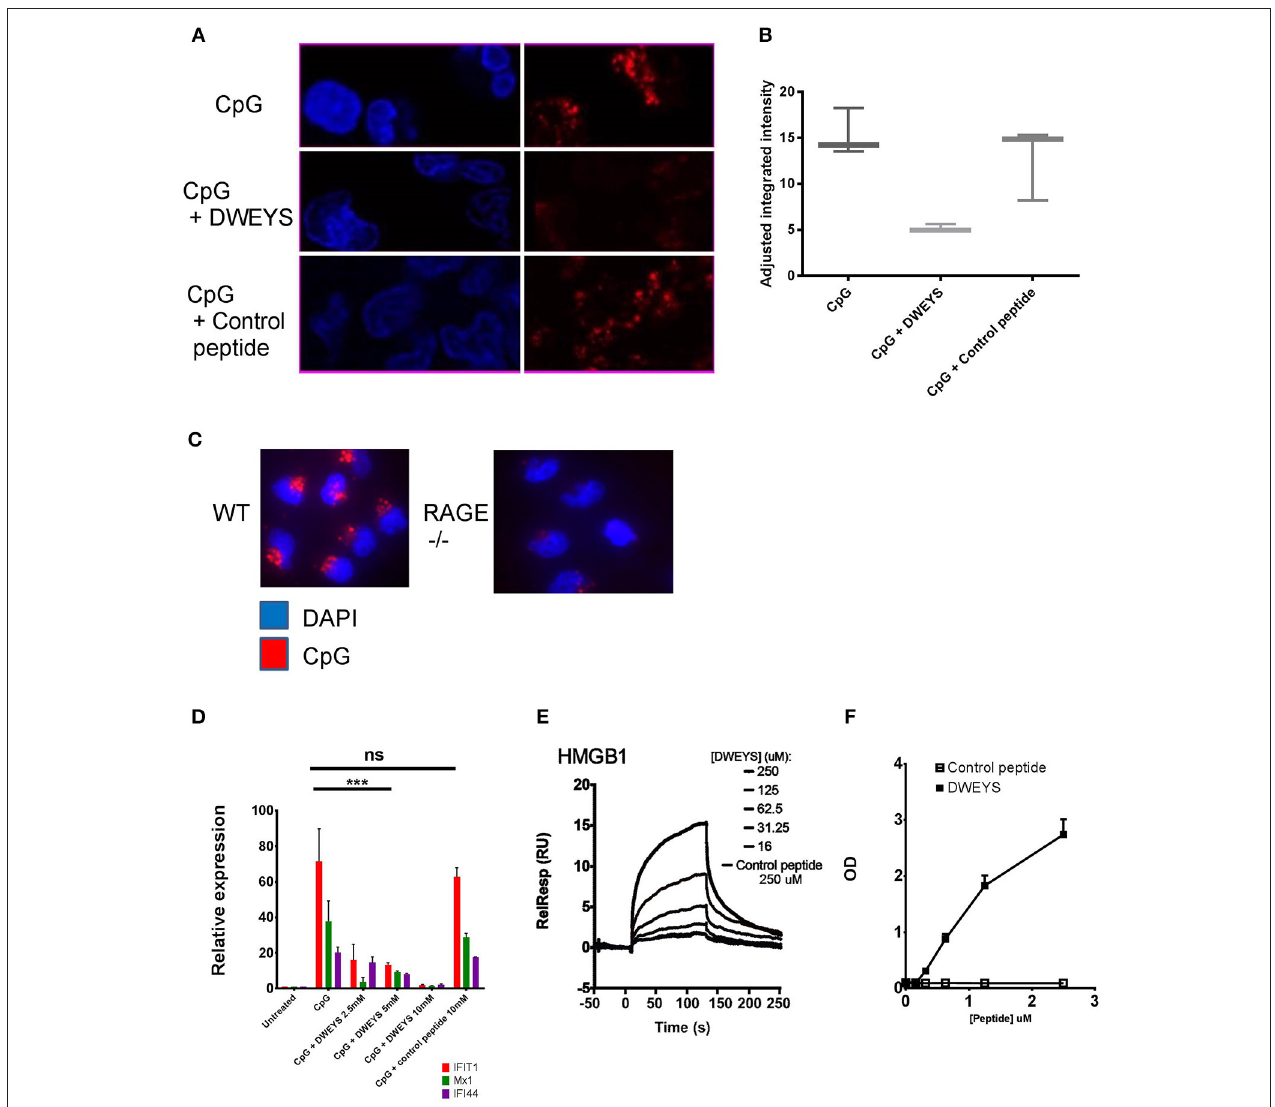
FIGURE 4 | DWEYS binds HMGB1 and inhibits its binding to RAGE. (A) Monocytes were incubated with labeled CpG (red) and DWEYS or control peptide for 20 min. Cells were counterstained with DAPI prior to imaging. (B) Depicts adjusted fluorescence intensity for three experiments run. (C) Monocytes from C57BL6 wild type (WT) or RAGE − / − mice were incubated with labeled CpG for 20 min and counterstained with DAPI prior to imaging. (D) Primary human monocytes were incubated with CpG and with or without DWEYS or a control peptide for 20 min. ISG expression was analyzed by qPCR. Data were plotted relative to untreated cells, and represents three independent experiments. (E,F) HMGB1-DWEYS binding analysis by biacore T200 (E) and ELISA (F) . HMGB1 was immobilized on a CM5 sensor chip and varying peptide concentrations were injected as noted in the methods section. DWEYS binds to HMGB1 with an apparent KD of 185 µ M. *** p < 0.001; ns, not